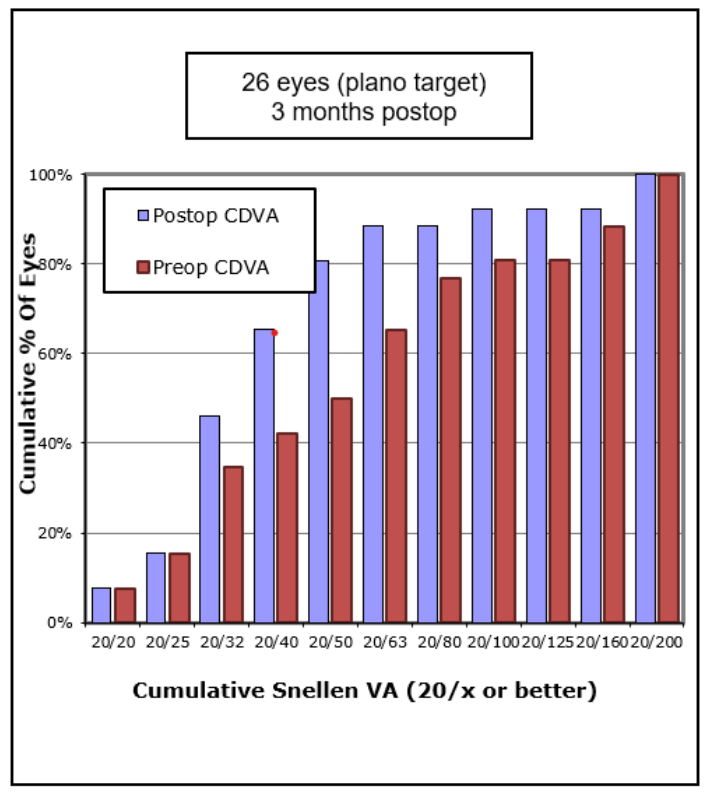
Figure 3. Cumulative pre-operative versus post-operative corrected distance visual acuity (CDVA) in 21 keratoconic eyes implanted with Ferrara intrastromal corneal ring segments.